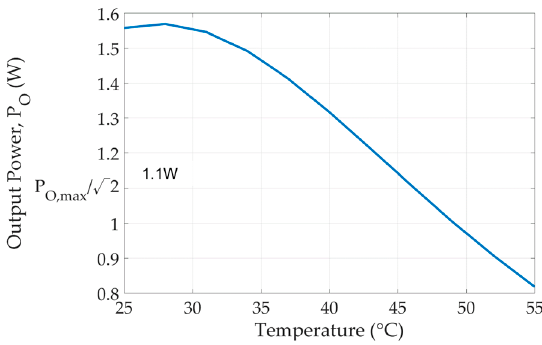
Figure 2. Variation in the output power with respect to temperature.